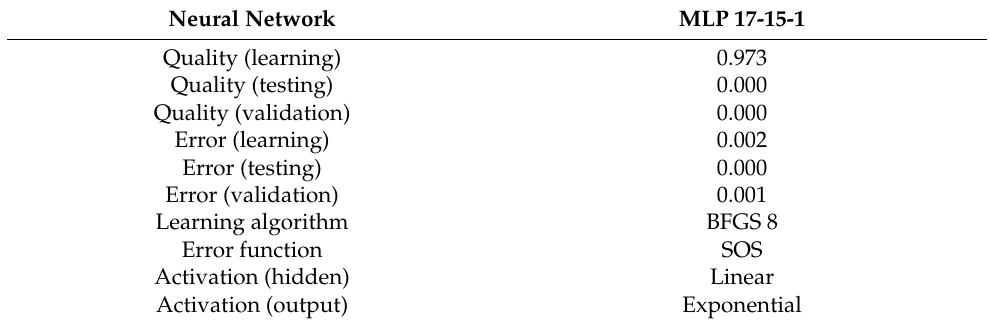
Table 13. Information about the neural network to sensitivity analysis of the proposed model.